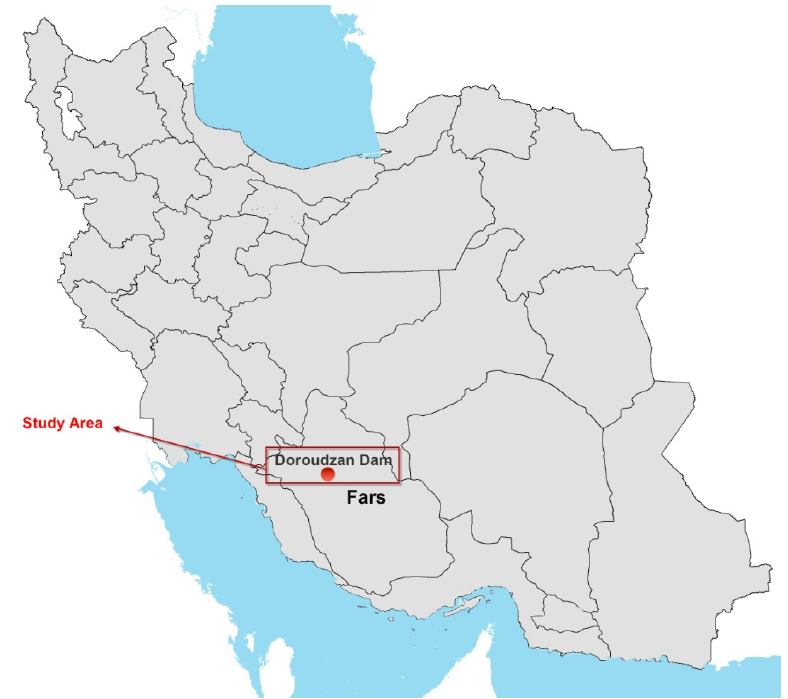
Figure 1. A general map of Iran illustrating the location of the study